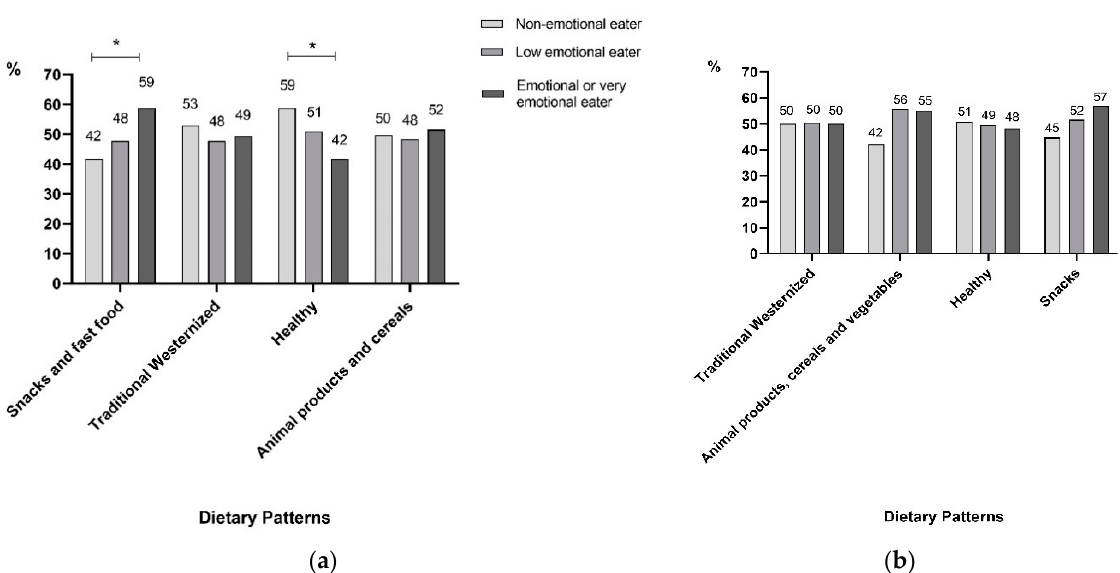
Figure 3. Adherence to dietary patterns according to the emotional eating classification in participants with and without abdominal obesity. This figure shows the adherence to dietary patterns according to the emotional eating classification in participants ( a ) with abdominal obesity or ( b ) without abdominal obesity. The emotional eating classification is presented in three categories: light gray for the non-emotional eaters, medium gray for the low emotional eaters, and dark gray for the emotional or very emotional eaters. The percentages expressed the proportion of subjects in the respective emotional category who adhered to each dietary pattern. It is important to notice that all subjects in a group (with abdominal obesity or without abdominal obesity) adhered or not to the four dietary patterns. * p < 0.05.